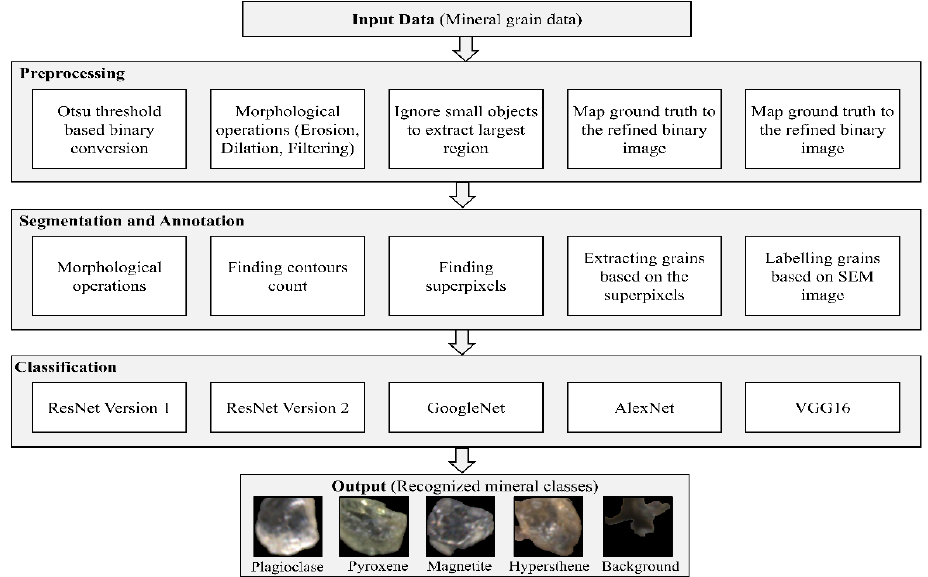
Figure 1. Workflow of the grains recognition method used in this paper.